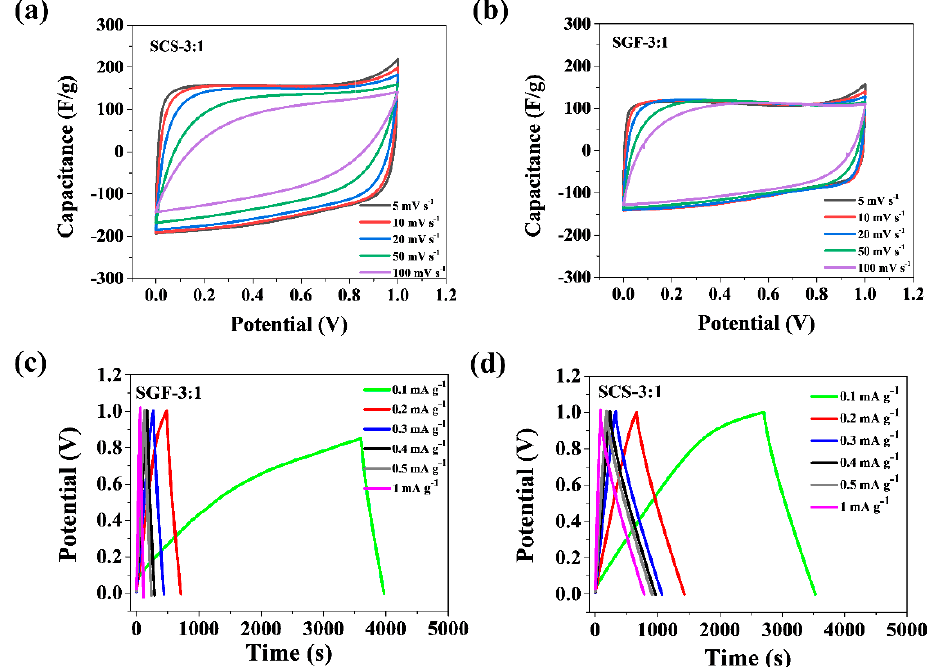
Figure 5. Electrochemical performance tests of the SCS-3:1 and SGF-3:1 samples: ( a , b ) cyclic voltammetry (CV) profiles at different scan rates ranging from 5 to 100 mV s − 1 ; ( c , d ) galvanostatic charge-discharge curves.